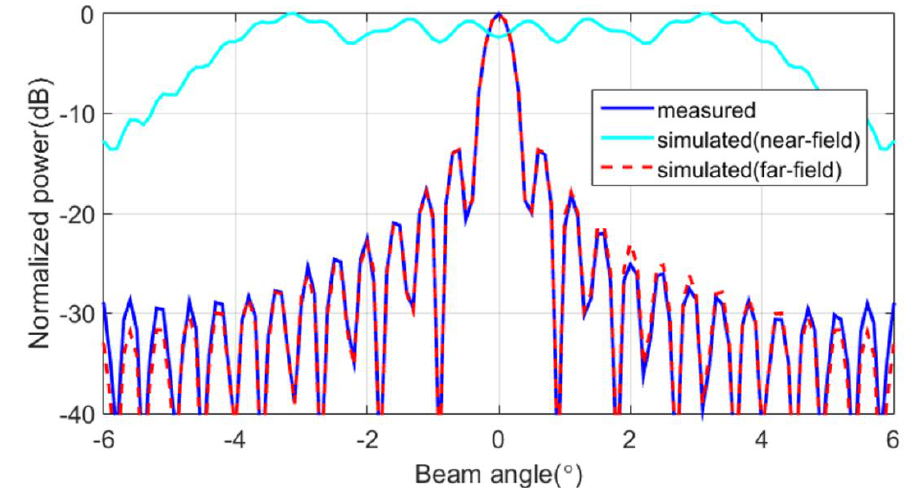
Figure 11. Subarray beam pattern to obtain total beam pattern using the proposed method. ( a ) subarray beam pattern obtained from near-field measurements and ( b ) sampling beam pattern.